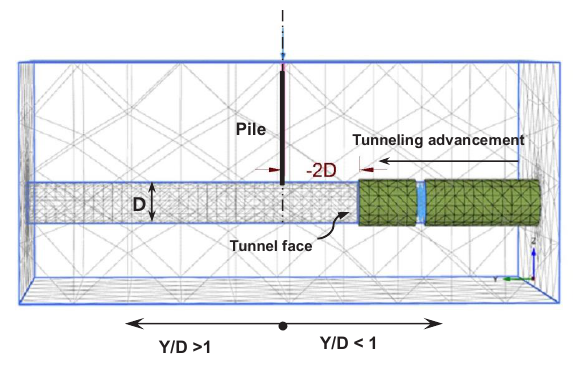
Fig. 4 The zone of infuence in longitudenal direction